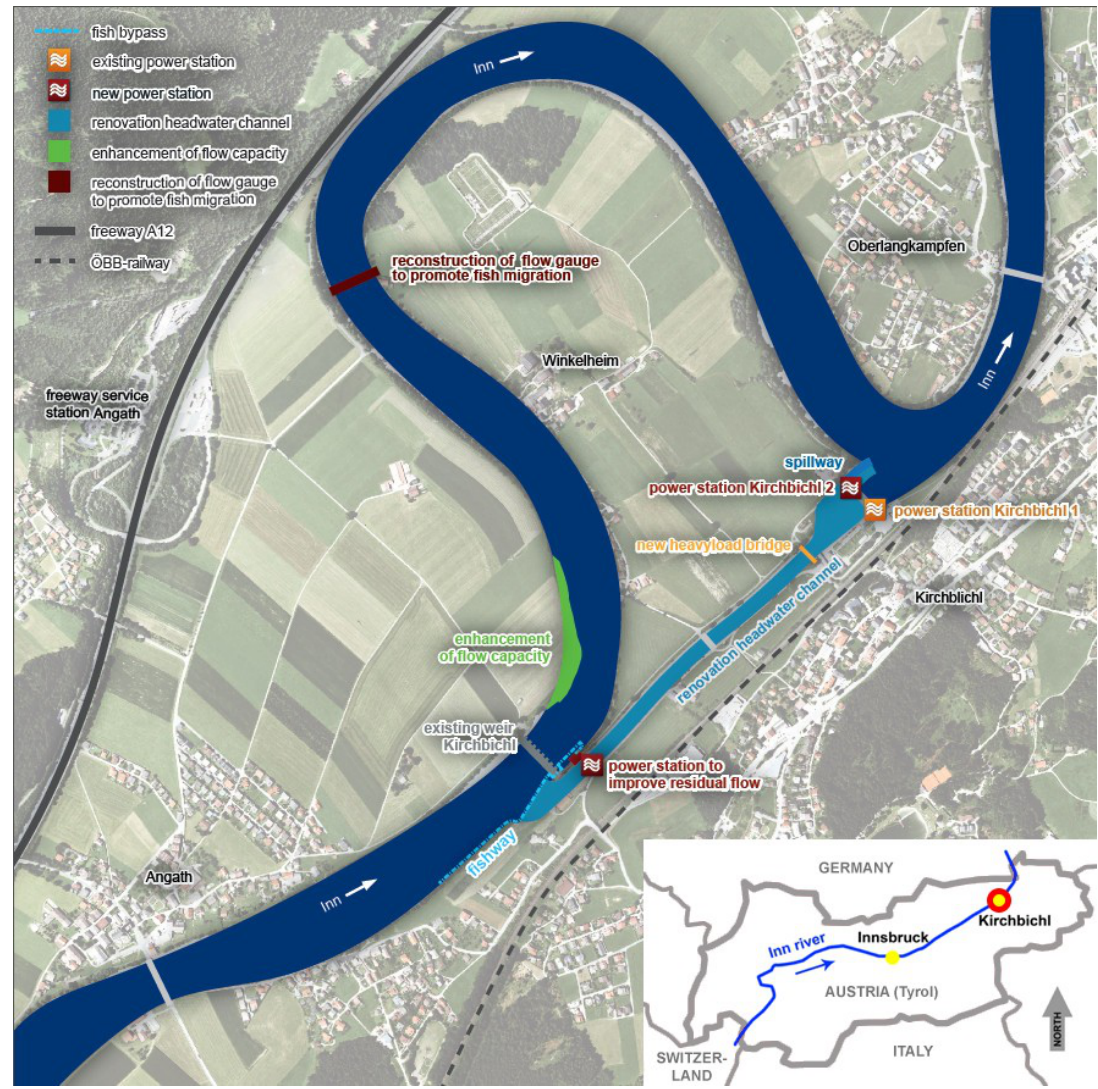
Figure 1. Overview on the study area, including information on the ongoing extension of the HPP Kirchbichl.